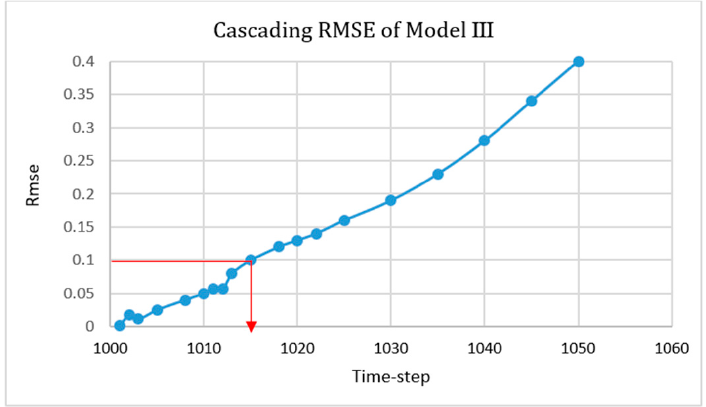
Figure 36. Root mean square equation (RMSE) of the cascading condition for Model Ⅲ .